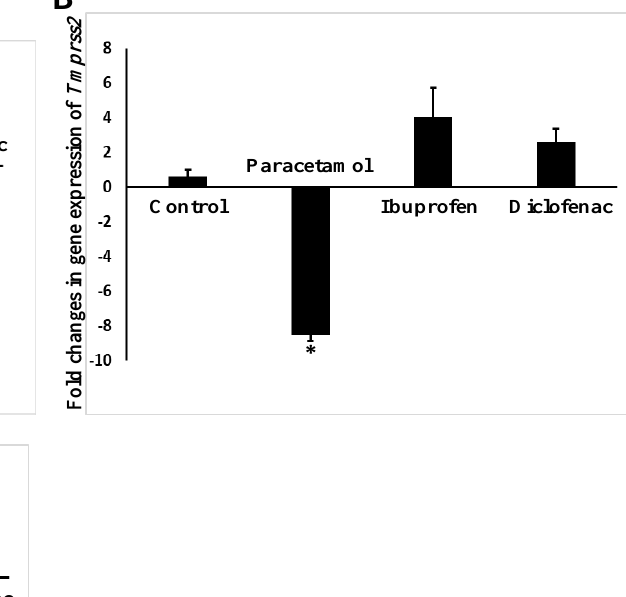
Figure 3. Relative mRNA expression of SARS-CoV-2 entry genes in the mouse lungs. * indicates a statistical alteration ( p <0.05, one-way ANOVA test).